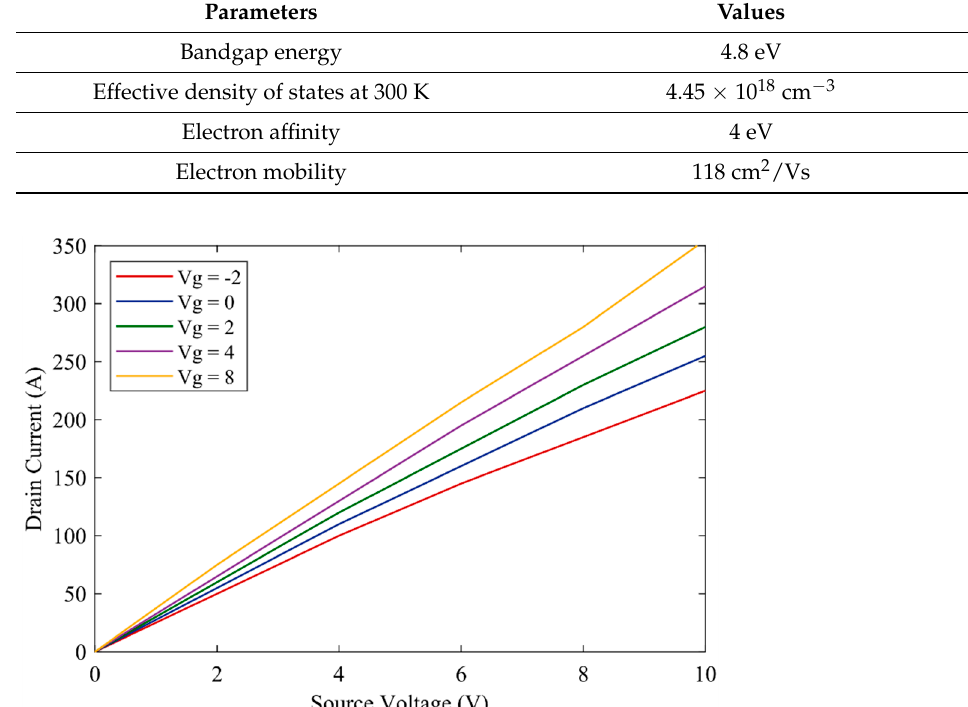
Figure 2. I-V characteristics of Ga 2 O 3 semiconductor switches.